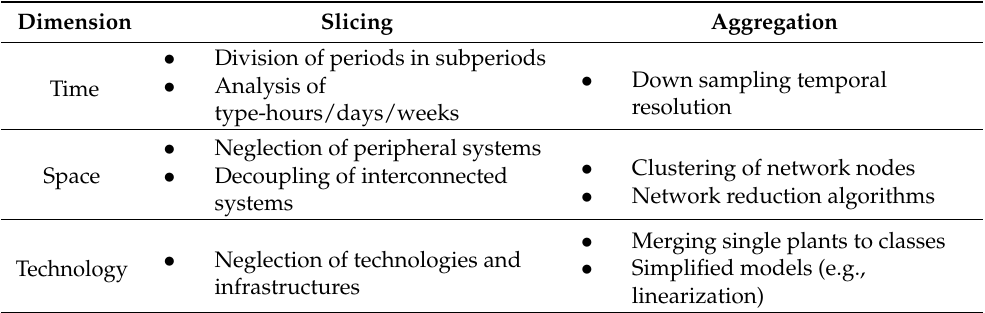
Table 2. Model reduction techniques based on